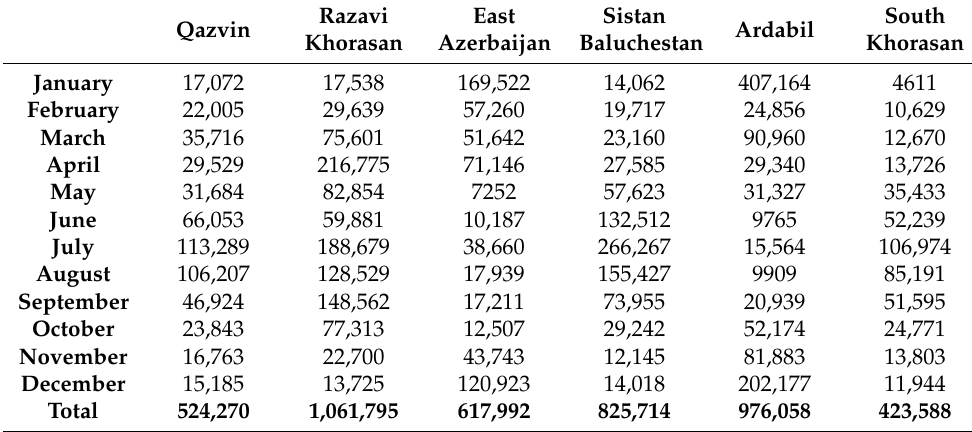
Table 3. Average monthly electricity generated by one Vestas V47 turbine, kWh (Most of the in- stalled turbines in the Iran are Vestas V47 660 KW turbines. See Appendix A, for detailed technical specifications and pricing of this